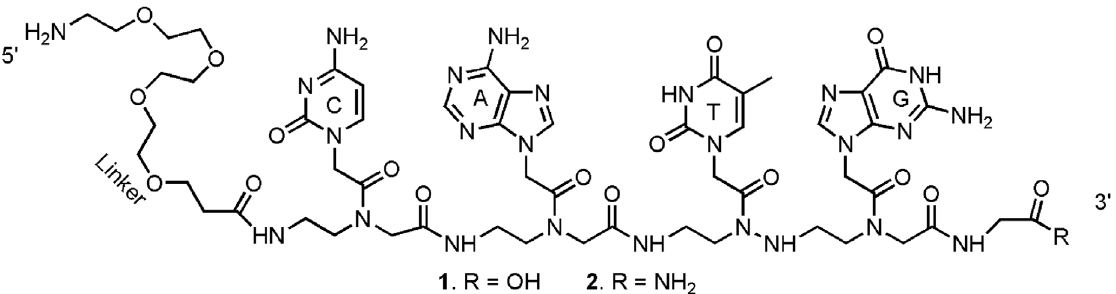
Figure 1. Structural representation of peptide nucleic acid (PNA) analog probes.